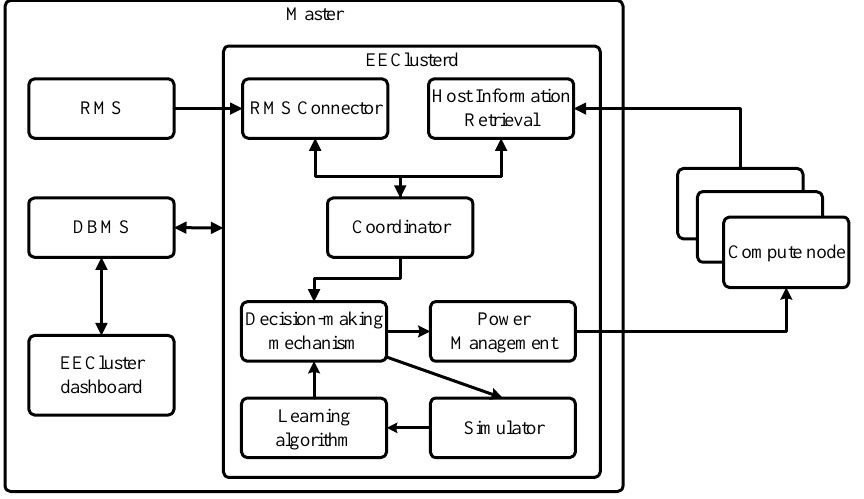
Figure 2. EECluster Tool: System components overview. DBMS: Database Management